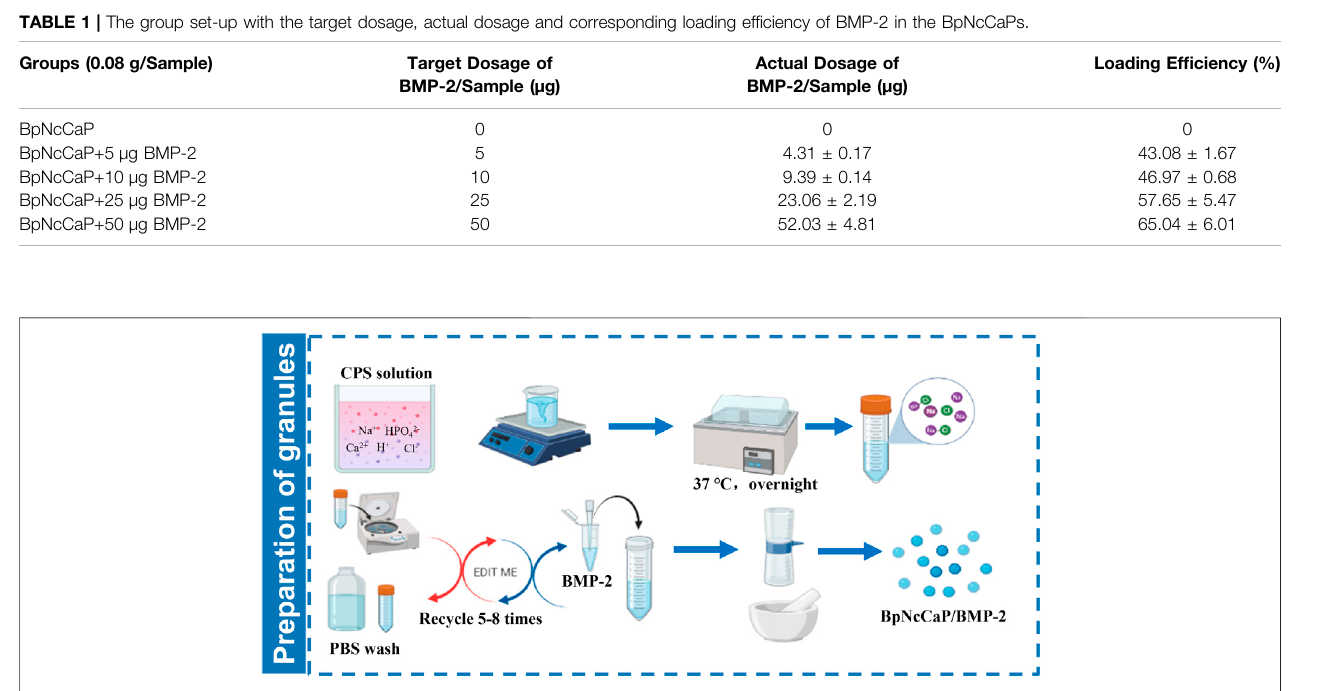
Frontiers in Bioengineering and Biotechnology |